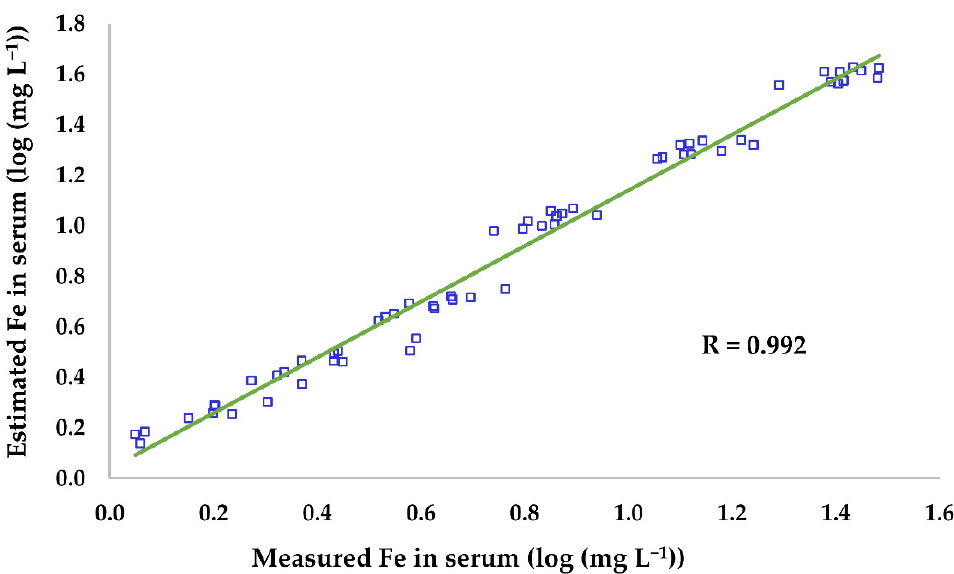
Figure 3. Correlation between the measured and estimated Fe concentrations (expressed as log (mg L − 1 )) in the graded haemolysed samples. Fe concentrations were estimated as the sum of the Fe concentrations in the blank, non-haemolysed samples and the Fe present in haemoglobin (1 g of haemoglobin contains 3.47 mg of Fe).